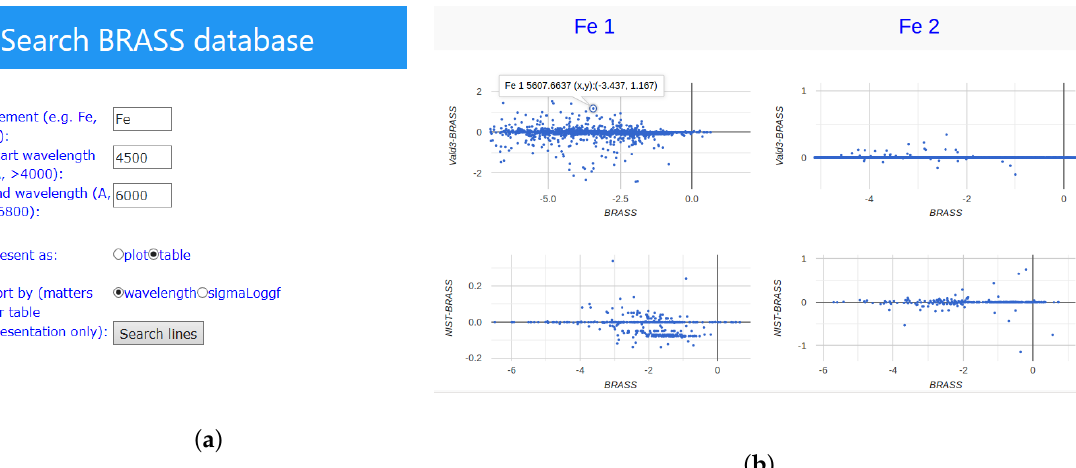
Figure 1. ( a ) The left-hand panel shows the Lines BRASS Data Interface query page. ( b ) The plot panels to the right show LBDI dynamic plots of BRASS log( gf )-values compared to the log( gf )-differences for VALD3-BRASS (top plot panels) and NIST-BRASS (bottom plot panels) of cross-matched Fe I and of Fe II lines ( see text ).